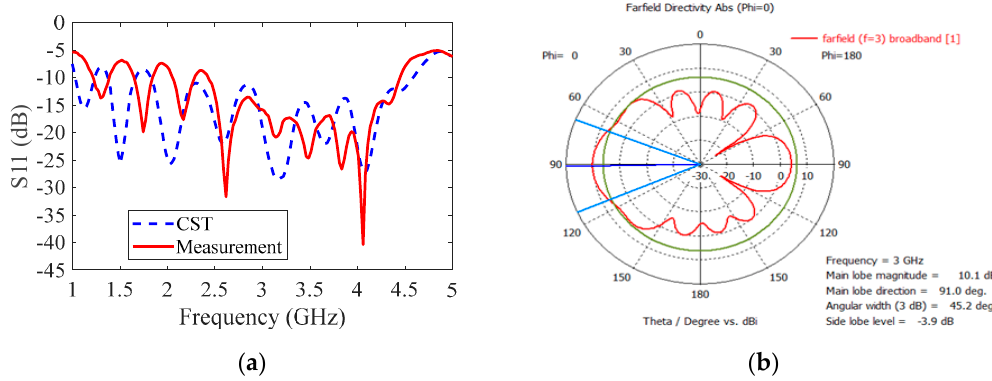
Figure 3. ( a ) comparison between the simulated and measured impedance matching (|S 11 | ≤ − 10 dB) of Tx and Rx Vivaldi antennas; ( b ) Simulated radiation pattern of the proposed Vivaldi antenna at the center frequency of 3 GHz with a high gain of 10.1 dBi and angular width of 45.2°.